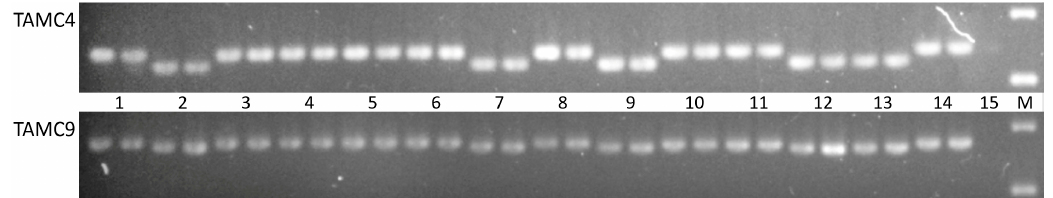
Figure 4. Amplified SSR markers TaCM4 and TaCM9 separated in 2% agarose gel electrophoresis. 1: L-15(2); 2: L-15(1); 3: L-17; 4: L-17(3)/Om29; 5: Om29/L-17(3); 6: L-55(2); 7: L-55(1); 8: L-55(4); 9: L-55(3); 10: wheat variety Omskaya 29; 11: L-23(2); 12: L-23(1); 13: barley L-319; 14: wheat variety Saratovskaya 29; 15: negative control (distilled water); M: GeneRuler 100 bp DNA Ladder.